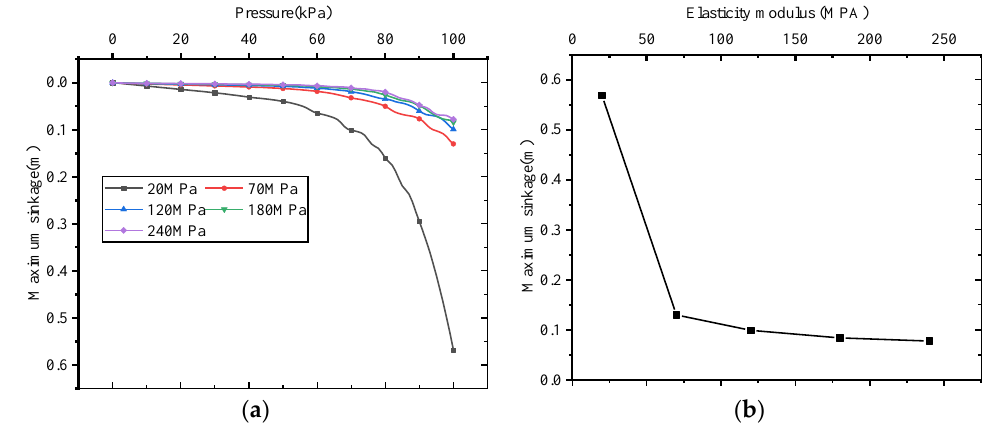
Figure 28. ( a ) Pressure-sinkage curves of different modulus of elasticity and ( b ) maximum sinkage comparison at 100 kPa case.